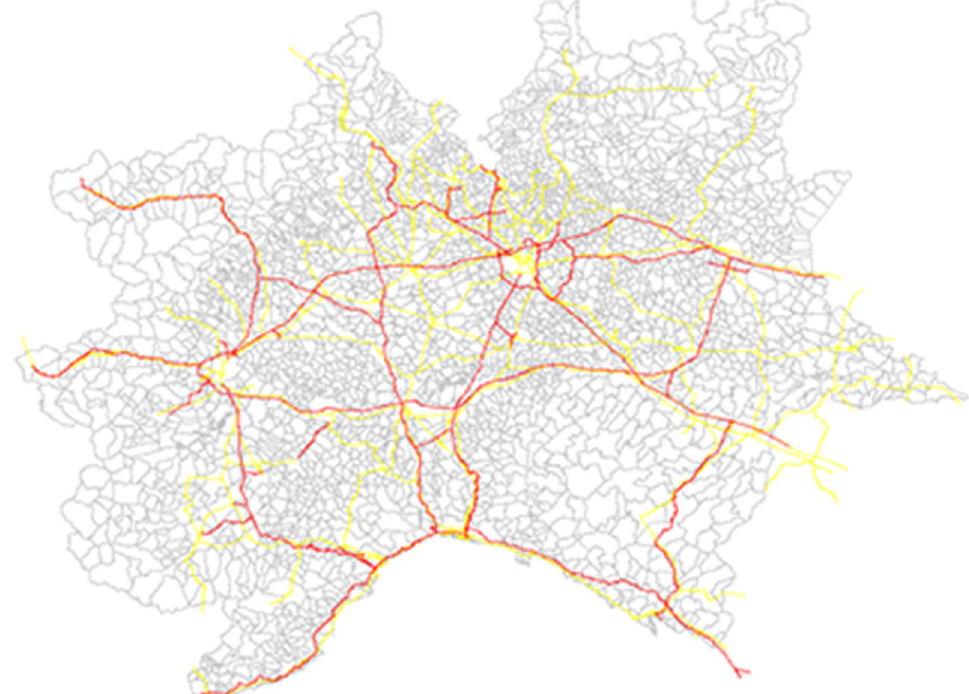
Fig. 1 Motorway and Rail Infrastructure in the north-western area of Italy. Source : Authors’ elaboration in MapInfo using Openstreetmap data. Red lines indicate motorways, yellow lines indicate